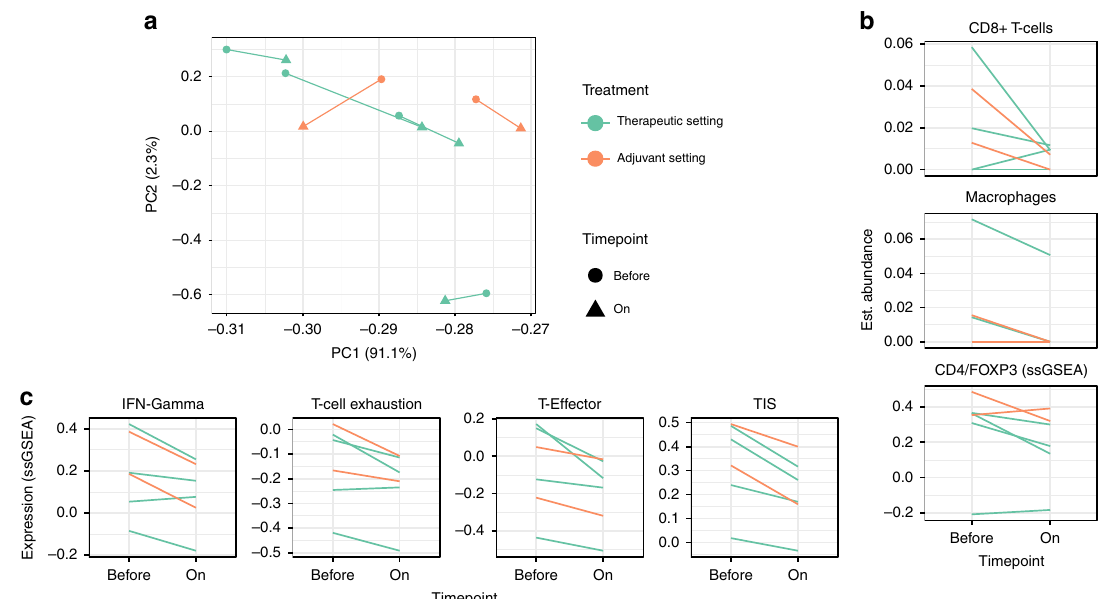
Fig. 5 Depletion of TIPB reduces tumor in fl ammation and CD8 + T cell numbers. a Principal component analysis of RNA-seq data from melanoma samples before (circles) and on (triangles) anti-CD20 therapy. On-therapy samples consist of metastases affected by anti-CD20 therapy (therapeutic setting, green lines) and of metastases that developed de novo in B cell-depleted patients (adjuvant setting, orange lines). Percentage numbers in axis labels represent the explained variation by each component. Lines link a patient ’ s samples. b xCell estimated abundance of cell types in tissue samples before and on anti-CD20 therapy. Abundance of CD4 + FOXP3 + was estimated using ssGSEA since no comparable xCell signature exists. c Expression of